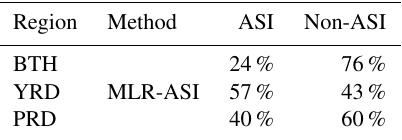
Table 2. Contributions of Arctic sea ice (ASI) and residuals (non- ASI) to the observed PM 2 . 5 trends in the winter seasons of 2013– 2018. Region Method ASI Non-ASI BTH 24% 76% MLR-ASI YRD 57% 43% PRD 40%